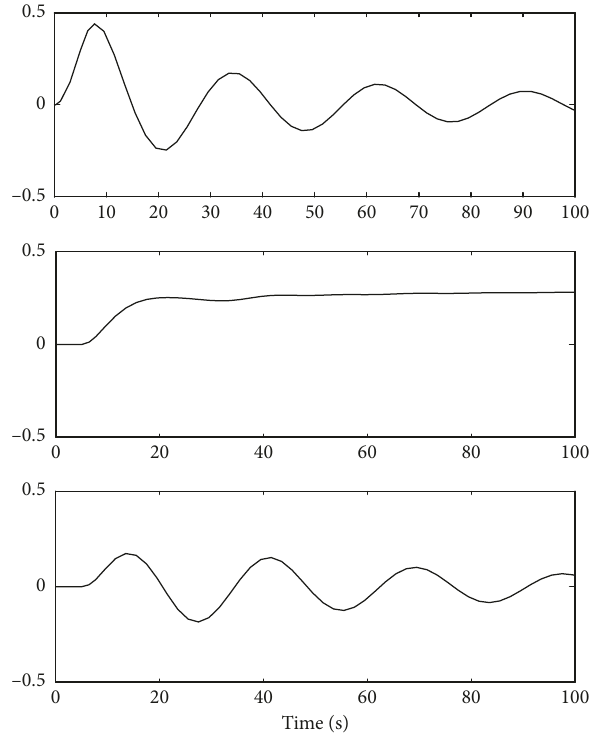
Figure 8: Output response under disturbance.